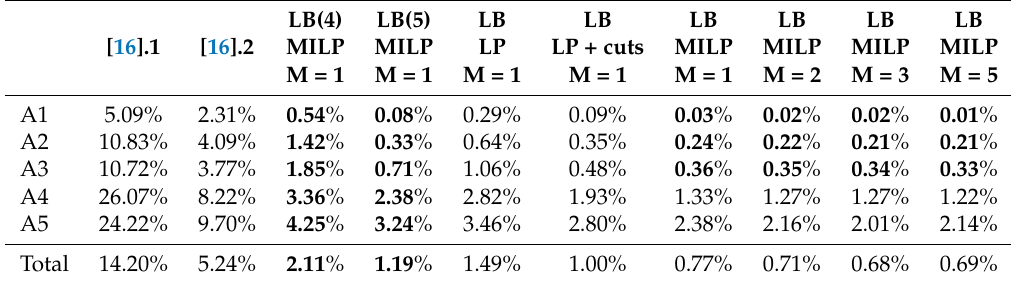
Table 6. Dual bounds for the dataset A, comparison of former dual bounds of the literature with the dual bounds LB ( k 0 ) with k 0 > 3 and LB without aggregation of production time steps and scenario decomposition. M indicates the maximal number of scenarios in sub-problems. MILP computation of dual bounds are stopped after 2400 × M seconds using Machine B. Bold values denote stopped computations with optimal dual bounds in the 0.001% tolerance for MILP computations. LP and LP + cuts are also the terminating values, no additional gap is implied by the time